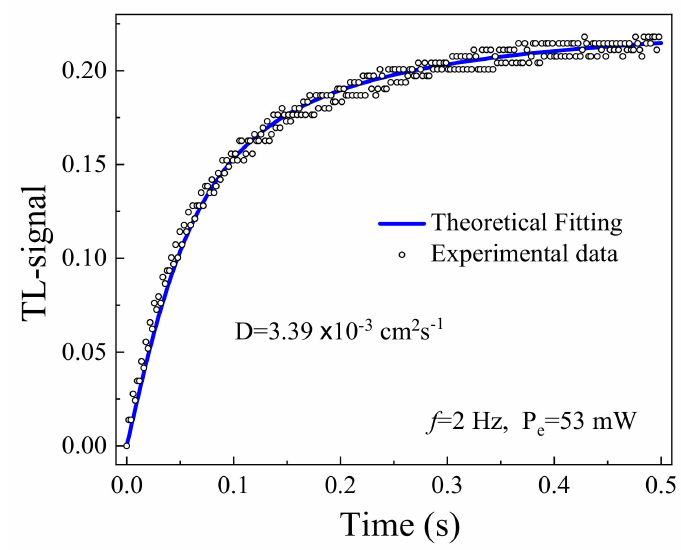
Figure 8. TL signal for the PMZE + 0.2 TiO 2 sample as function of time.